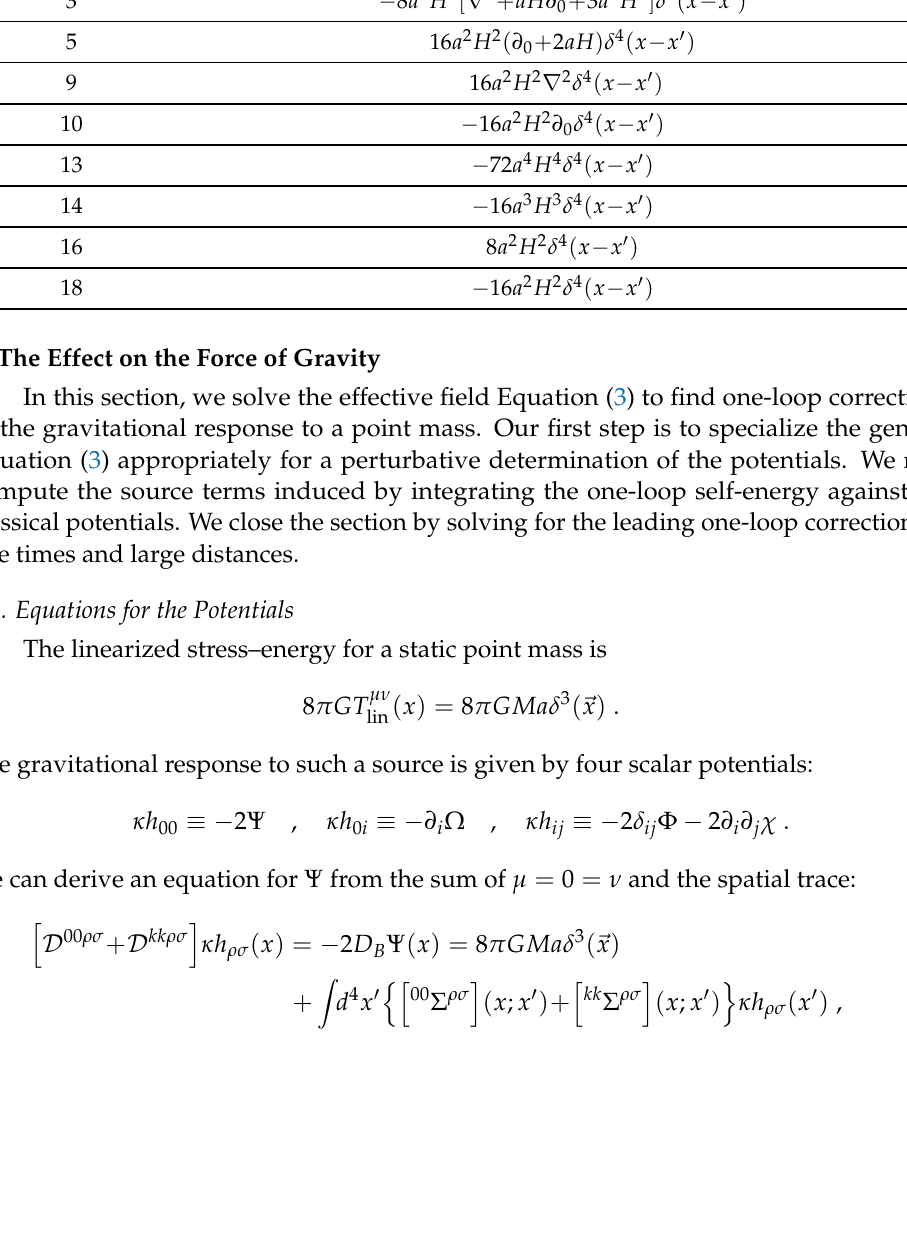
2 ln ( a ) . 32 π 2 ( x ; x (cid:48) ) from the 4-Point SK